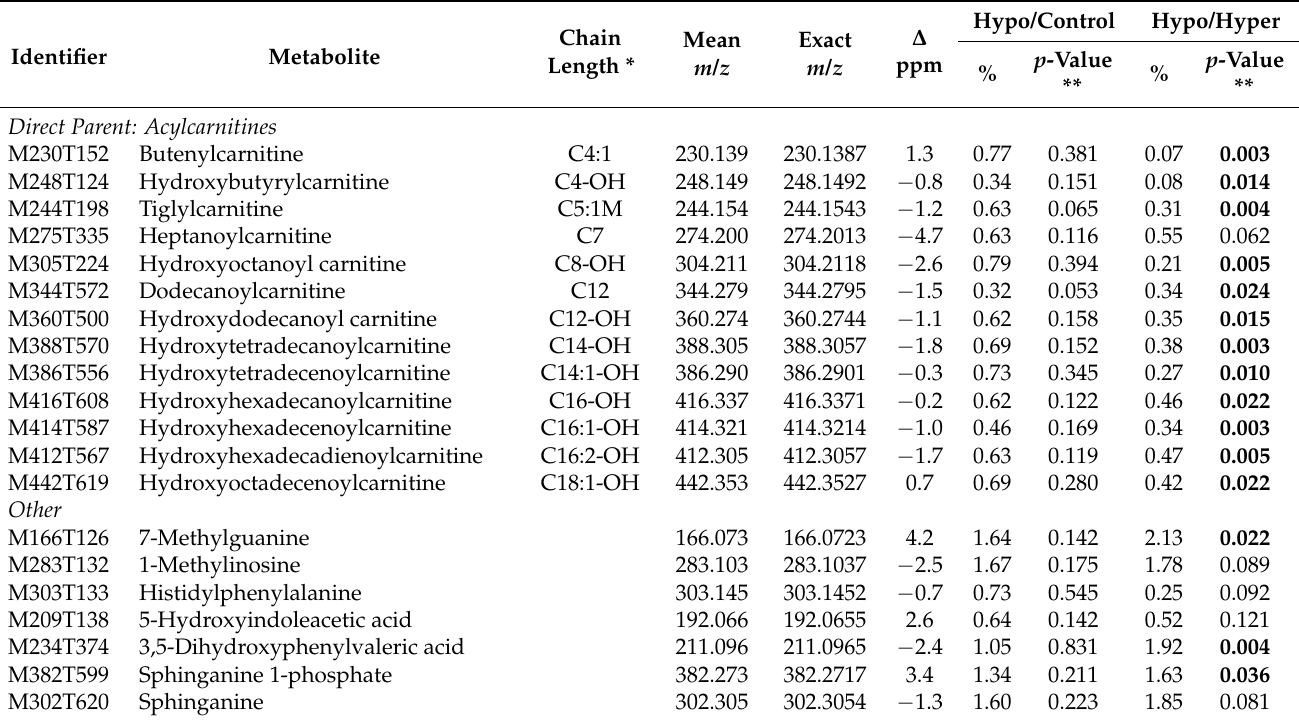
Table 3. Identified metabolites discriminating the hypo group from the hyper and control